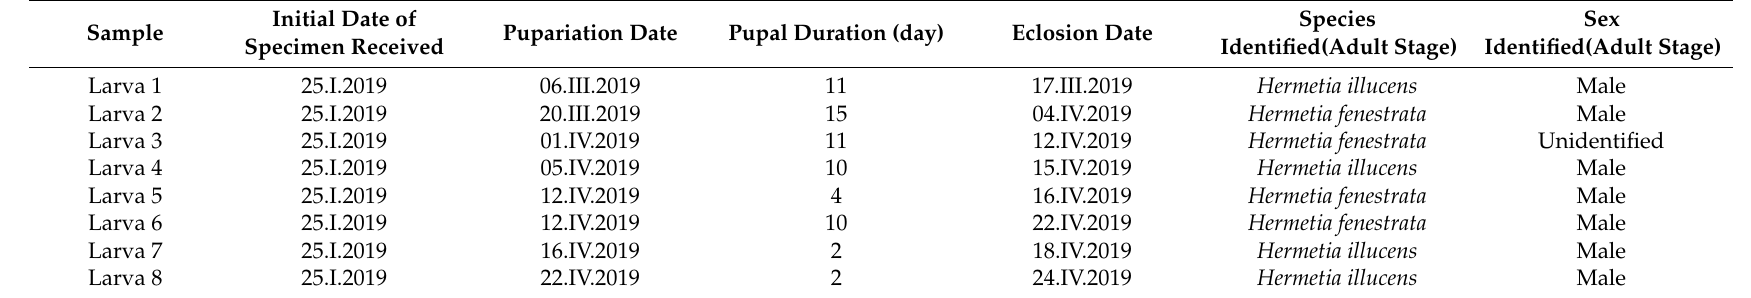
Table 1. Development data of Hermetia illucens and H. fenestrata found in stingless bees Geniotrigona thoracica nest collected from Negeri Sembilan, Peninsular Malaysia. Larvae and pupae were reared under laboratory conditions at 22 ◦ C and 60–70%